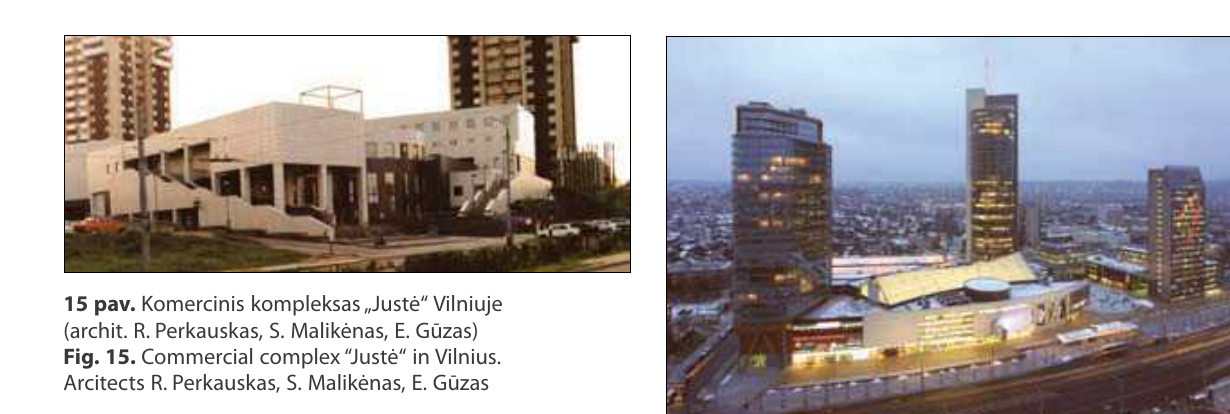
Fig. 15. commer­cial complex “Ju­stė“ in Vilniu­s.